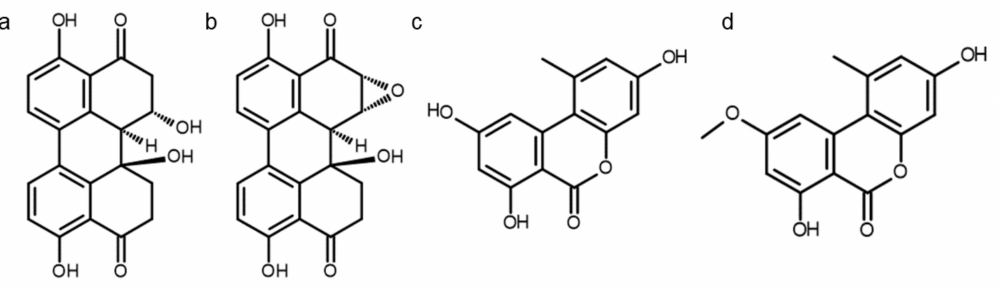
Figure 1. Chemical structures of ( a ) ATX-I, ( b ) ATX-II, ( c ) AOH and ( d )